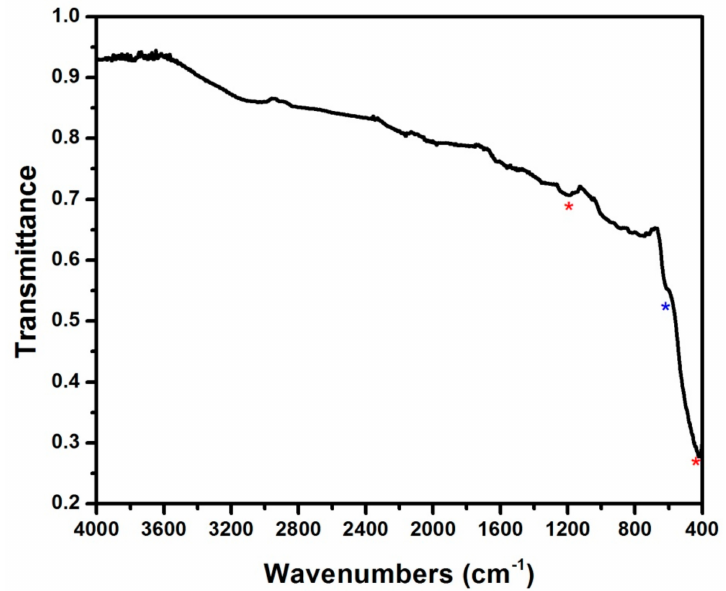
Figure 5. Fourier transform infrared (FTIR) spectrum of the NiCo 2 O 4 / MnO 2 hierarchical